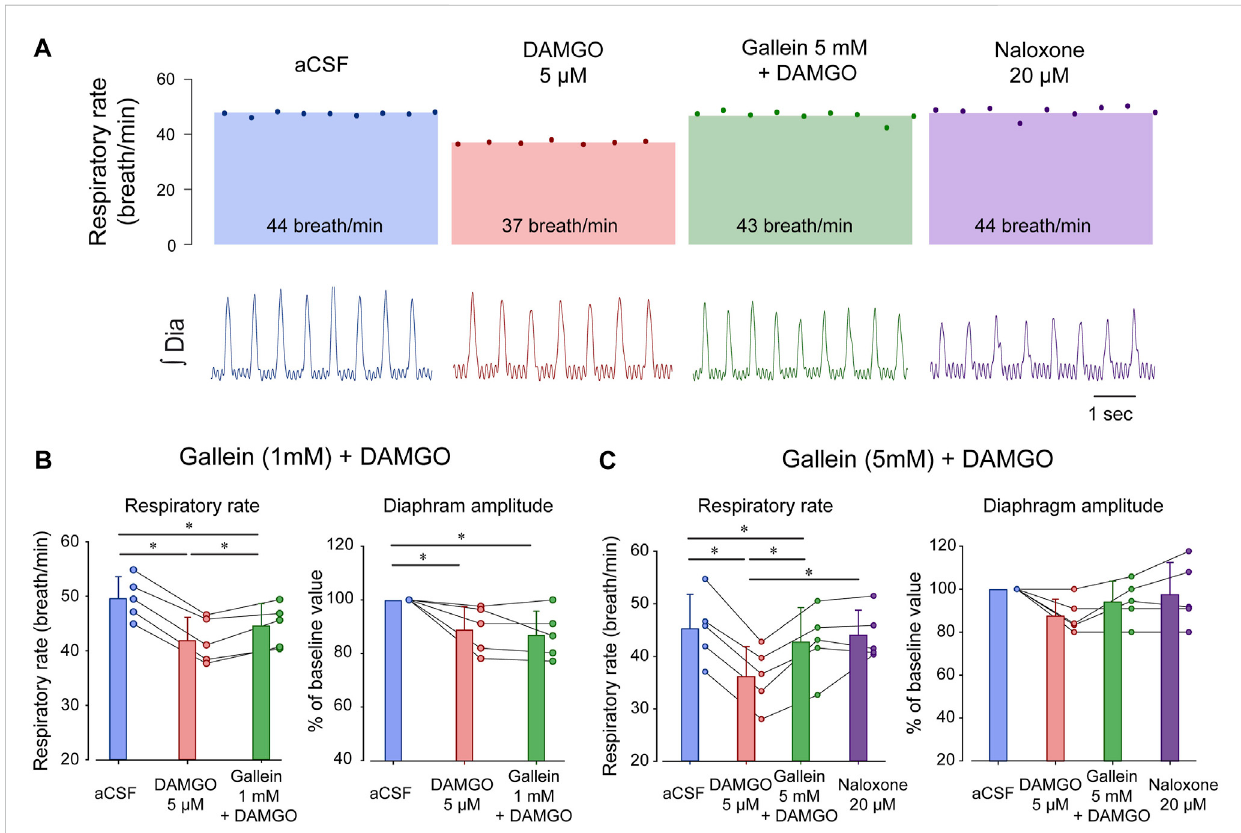
FIGURE 2 Inhibitionof βγ proteinsreversesrespiratoryratedepressionbytheMORagonistDAMGO. (A) DAMGOreducedrespiratoryratebyabout15.5%when compared to aCSF or vehicle, and this reduction was reversed by gallein at 5 mM, but only partially at 1 mM. Naloxone did not increase respiratory rate beyondtheaCSFor galleinvalues. (B) DAMGO reducedrespiratory ratecompared toaCSF andgallein (1 mM)partially reversedrespiratoryrate.Although diaphragm amplitude was reduced by DAMGO, this reduction was not reversed by gallein. (C) DAMGO signi fi cantly depressed respiratory rate, an effect completely reversed by gallein at 5 mM. No effects were observed in diaphragm amplitude. aCSF, arti fi cial cerebrospinal fl uid. MOR, µ-opioid receptors. Bars show means ± SEM. Each circle represents an individual experiment. * indicate means signi fi cantly different with p < 0.05